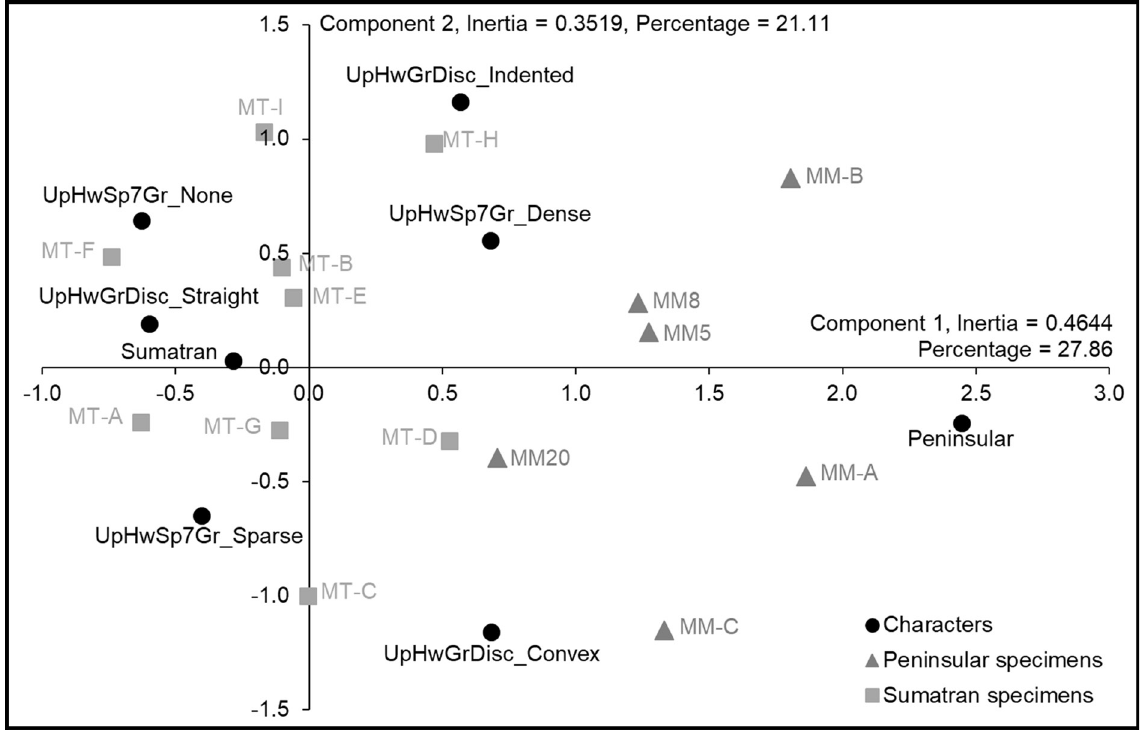
Fig. 6. Two-dimensional plot of correspondence analysis components 1 and 2 for males. Specimens with identical coordinates are grouped together (e.g., mT-A = male, Sumatra, group A; mm-A = male, Peninsular malaysia, group